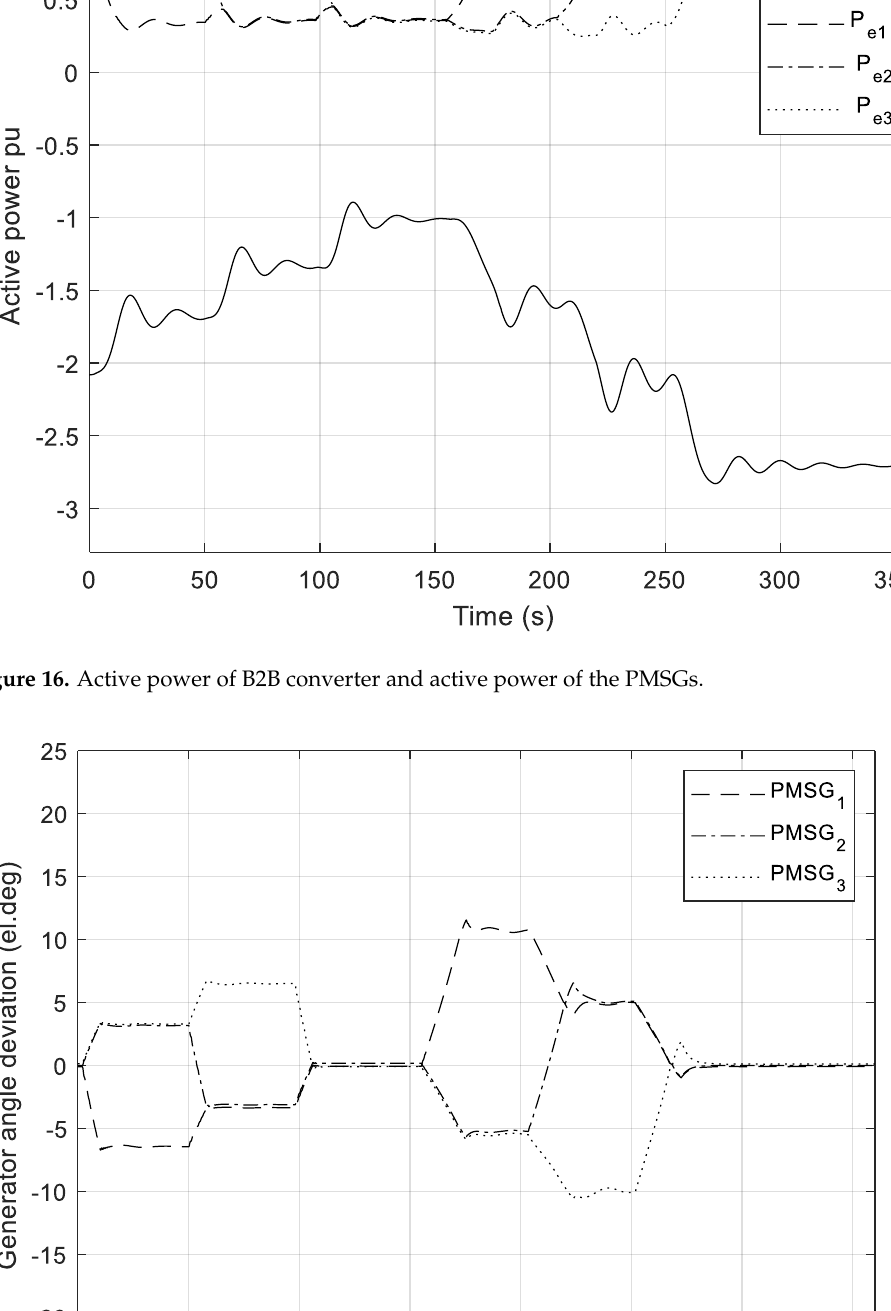
Figure 18. Current of the B2B converter and currents of PMSGs.